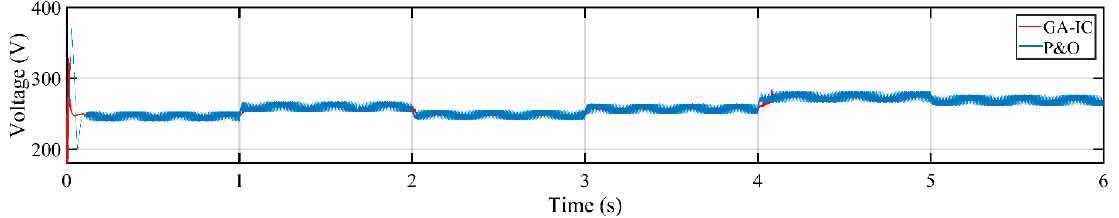
Figure 33. Case 3 power, detailed comparison of modified GA-IC vs. P&O. Energies 2020 , 13 , x FOR PEER REVIEW